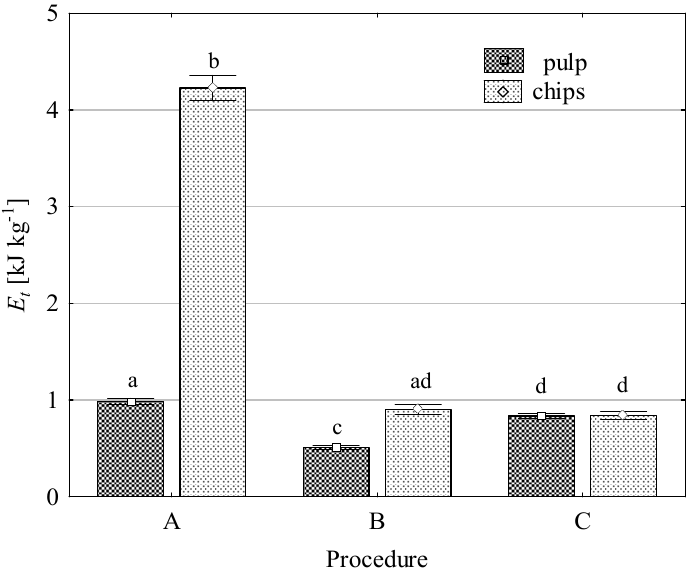
Figure 6. Impact of applied procedures on the total specific energy E t of pressing juice from celeriac. Abbreviations, as in Figure 3. a, b, c, and d—average values marked with the same letter show no statistically significant difference ( p ≤ 0.05).